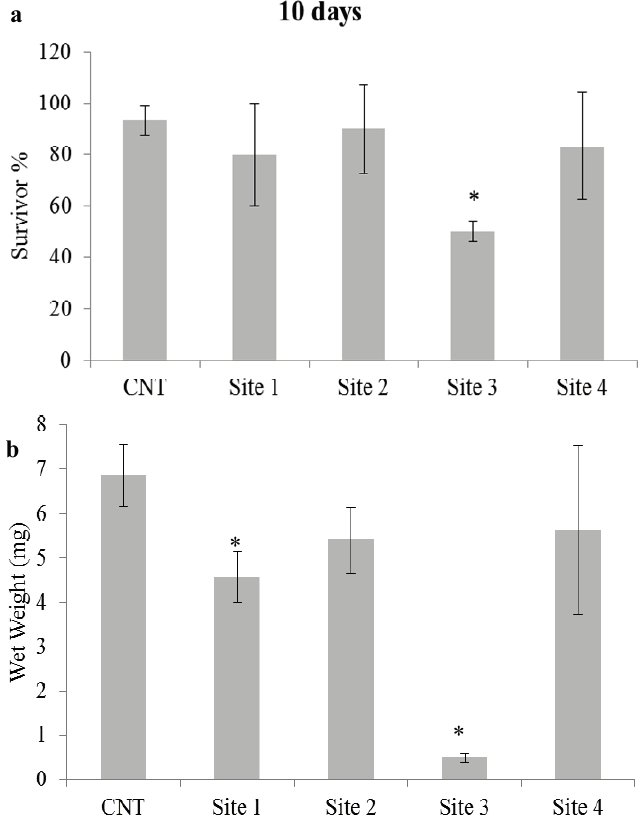
Figure 3. 10-days chironomids exposure test. ( a ) The percentage of chironomid larvae surviving in the control (CNT) and at each site (±SD) after 10 days of exposure; ( b ) the average wet weight (W.W. ± SD) of chironomid larvae after 10 days of exposure. Significant differences (one-way ANOVA, Dunnett’s post hoc test; p < 0.05 *) with the control are